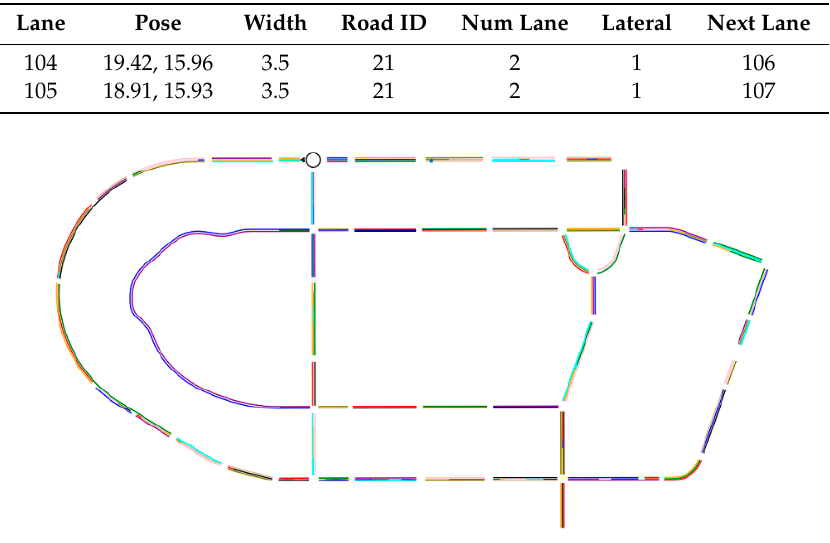
Figure 12. Trajectory centerline layer of the HD-Map.